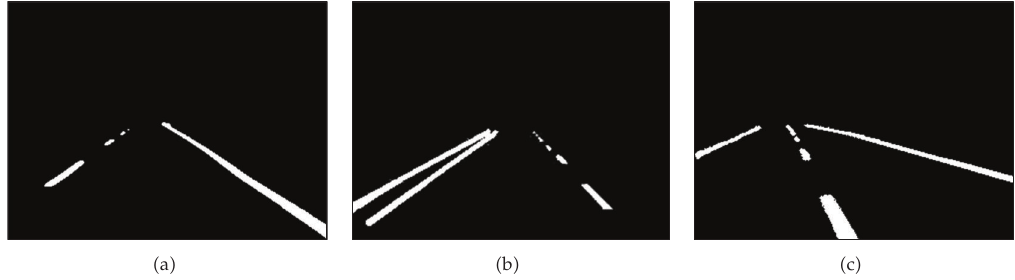
Figure 6: Road images after threshold and noise filtering. (cid:2) a (cid:3) Normal condition, (cid:2) b (cid:3) existing interference, (cid:2) c (cid:3) Deviation